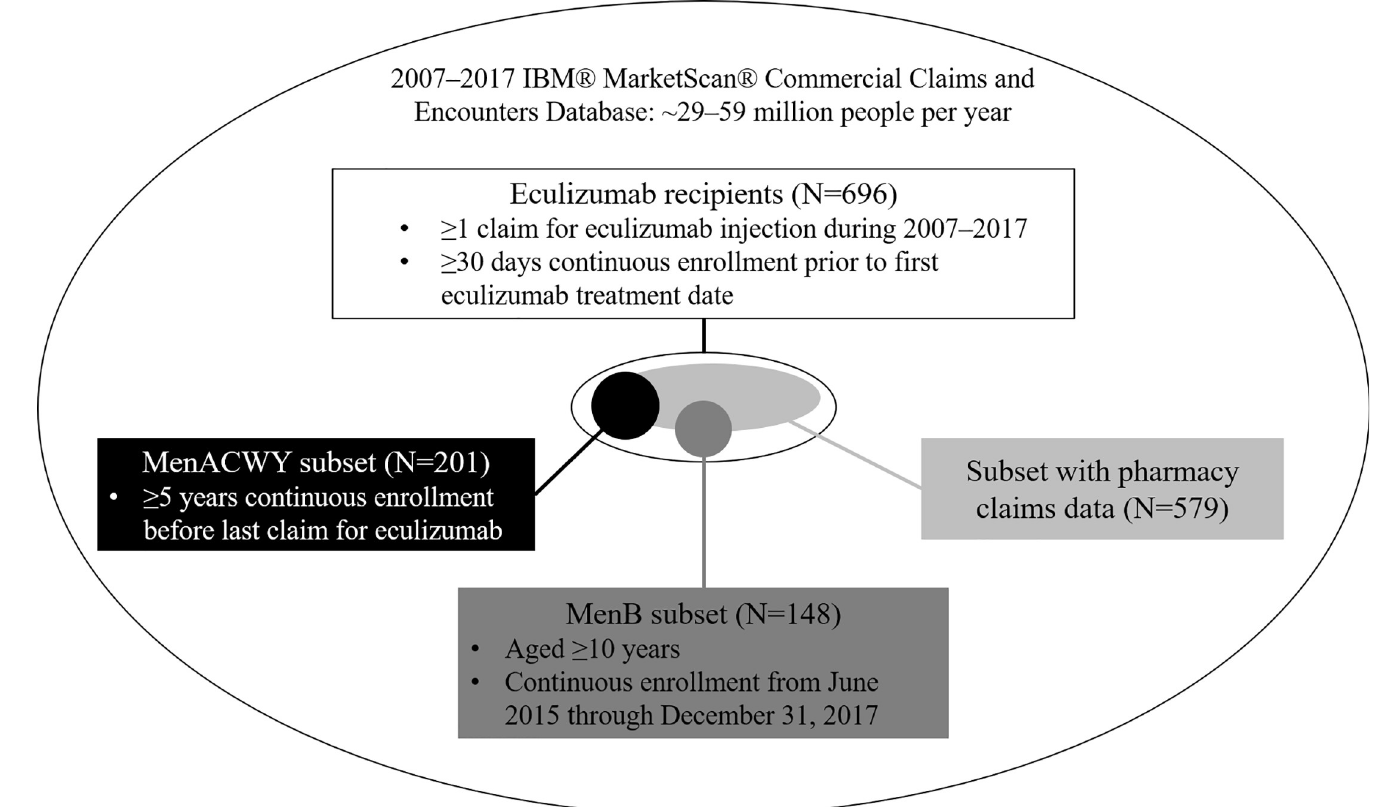
Fig 1. Inclusion criteria for full analytic cohort and sub-cohorts in the IBM Marketscan Commercial Database, 2007–2017.